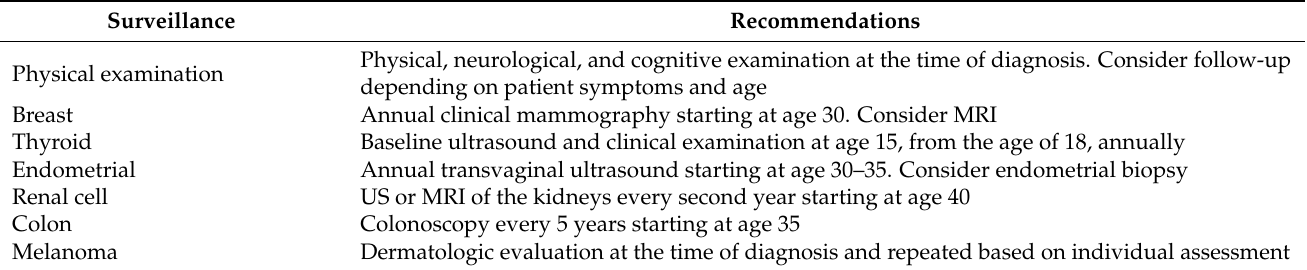
Table with inspiration from Smerdel et al. 2020, European Journal of Medical